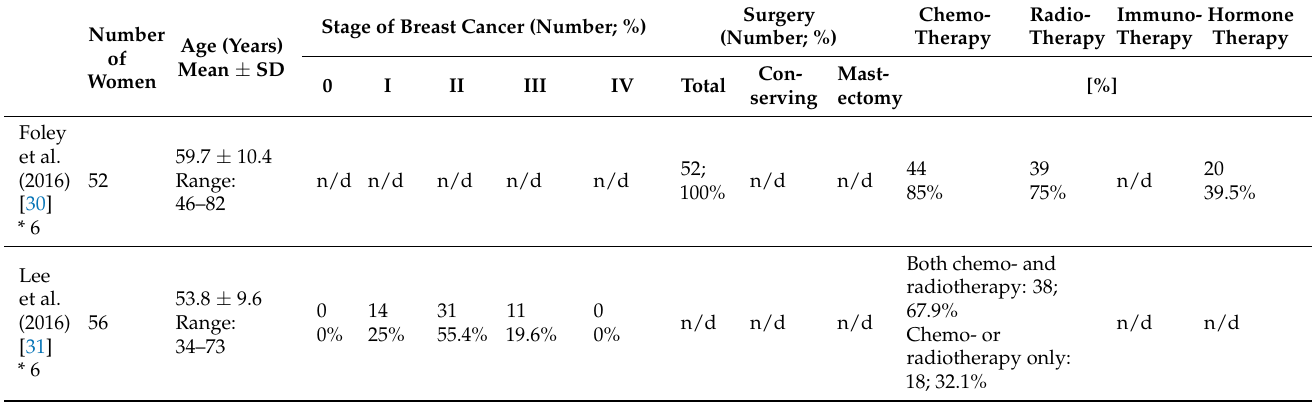
Table 5. Characteristics of the groups in pilot clinical trials.